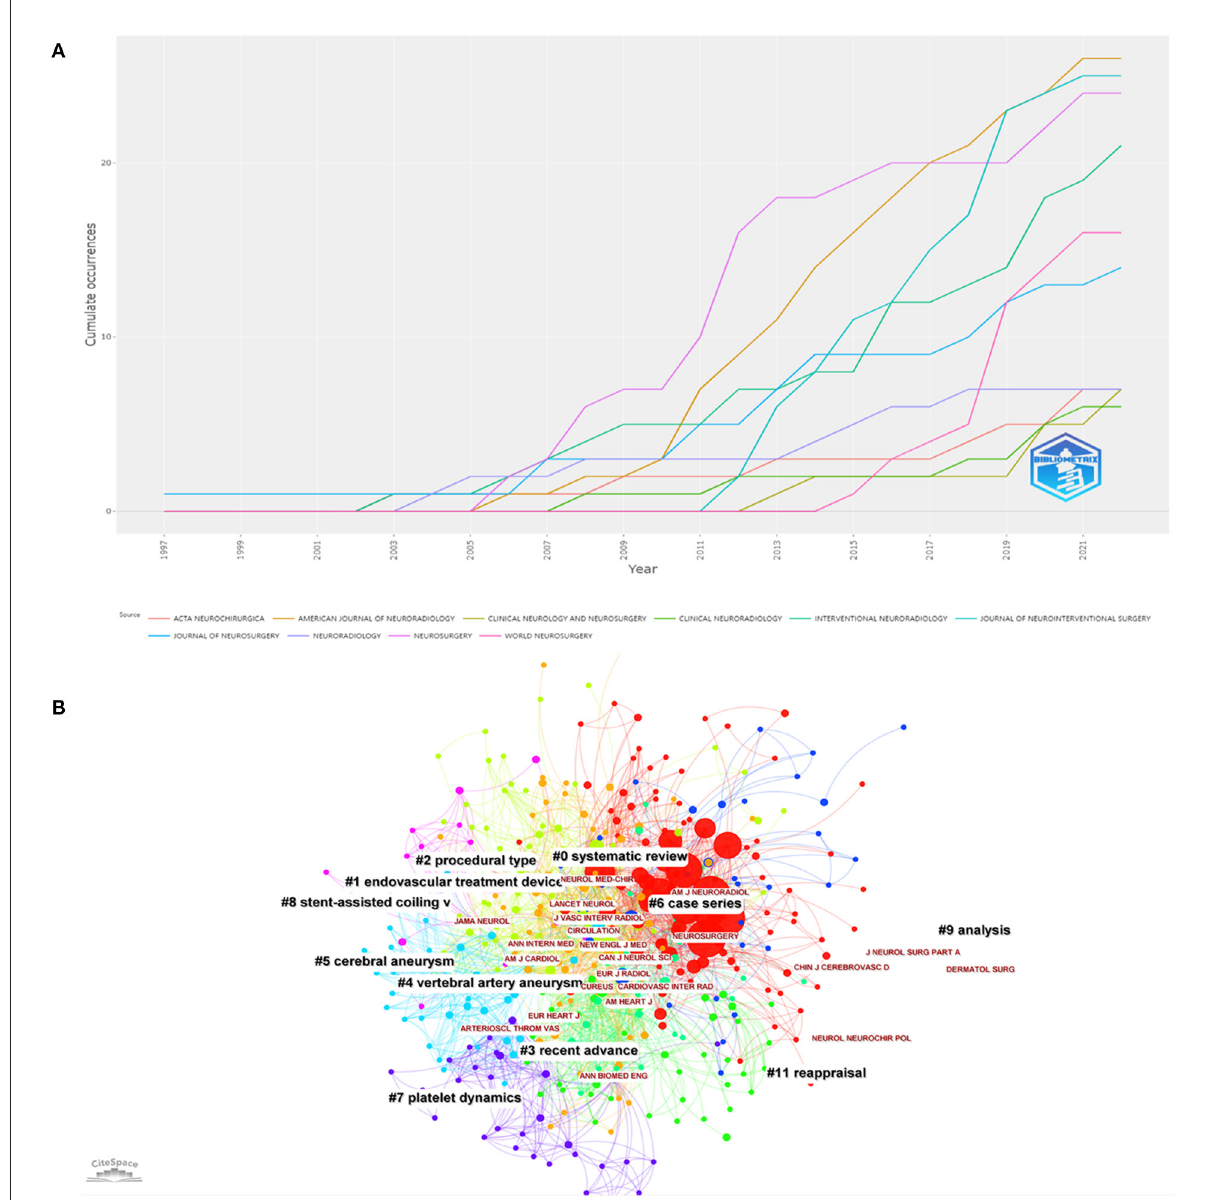
FIGURE6 (A) Source growth of publications. (B) The co-cited journal network with cluster